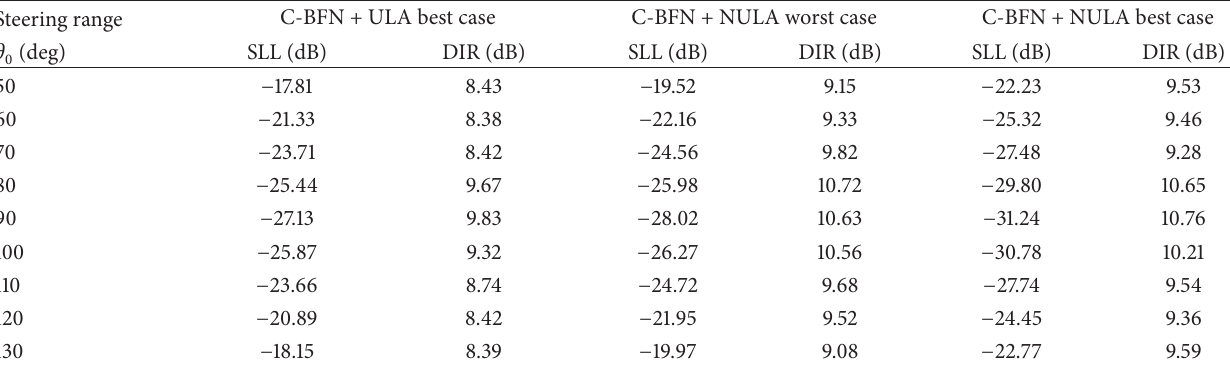
Table 3: Numerical values of side lobe level and directivity for the multiple beamforming network with a uniform and nonuniform linear array for beam number 2. Steering range C-BFN + ULA best